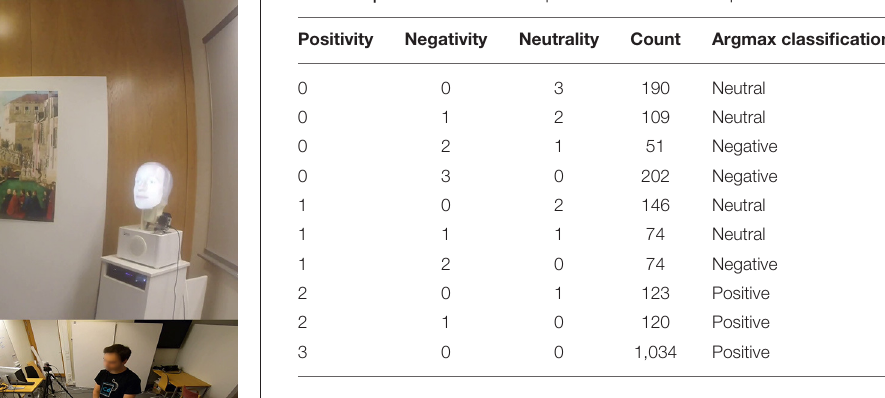
TABLE 1 | The distribution of output features across all